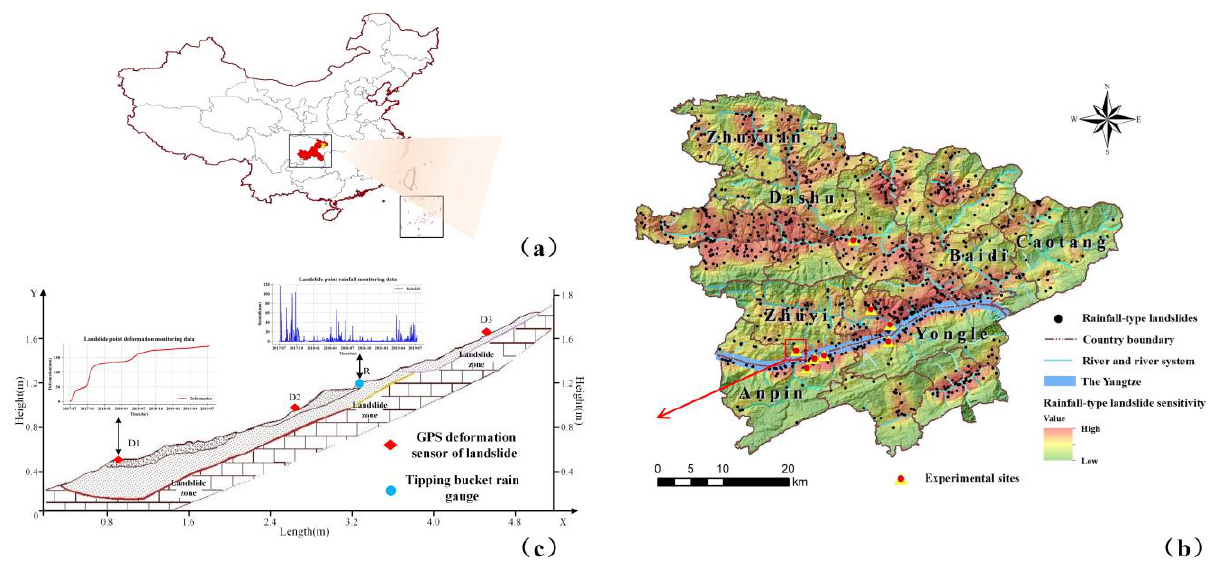
Figure 1. Location of the study area. ( a ) General map of China; ( b ) Location of the study area; ( c ) The XP landslide, briefly showing the monitoring instruments placed and the associated monitoring data.